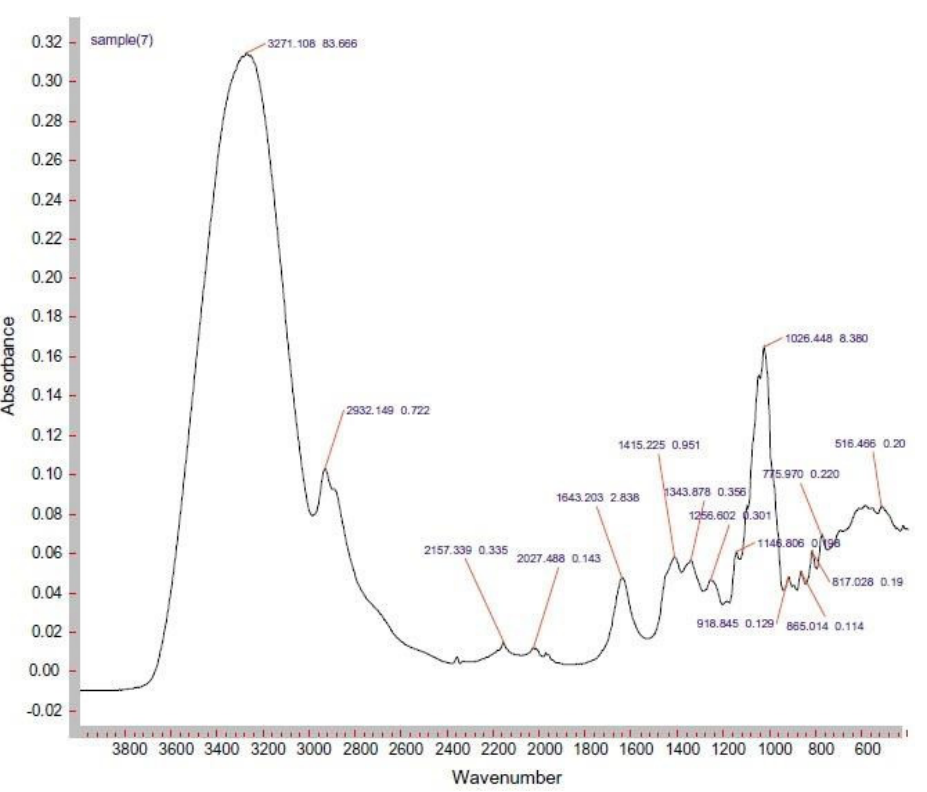
Figure 5. Representative FTIR–ATR spectrum of saffron honey in the 4000–400 cm − 1 spectral region. (Reprinter with permission from ref. [39]).